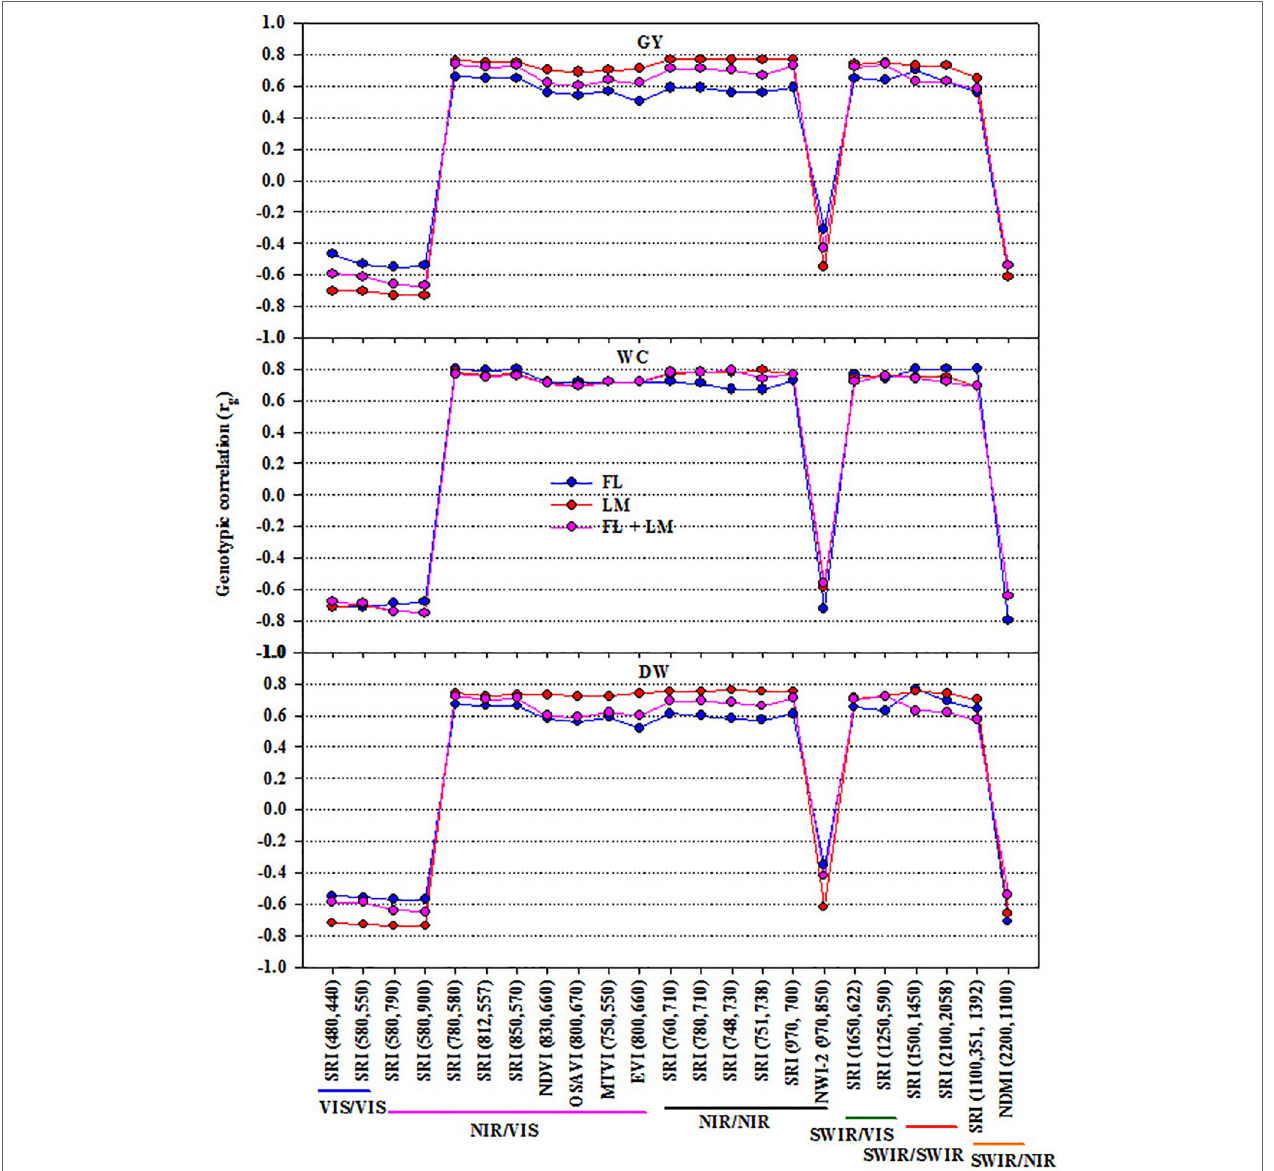
FIgURe 3 | Genetic correlations between different spectral reflectance indices and measured parameters (shoot dry weight per square meter (DW), water content of aboveground biomass (WC), and grain yield per hectare (GY)) under full irrigation (FL), limited irrigation (LM), and the combined two treatments (FL+LM). R 2 values ≥ 0.50 are significant at alpha =